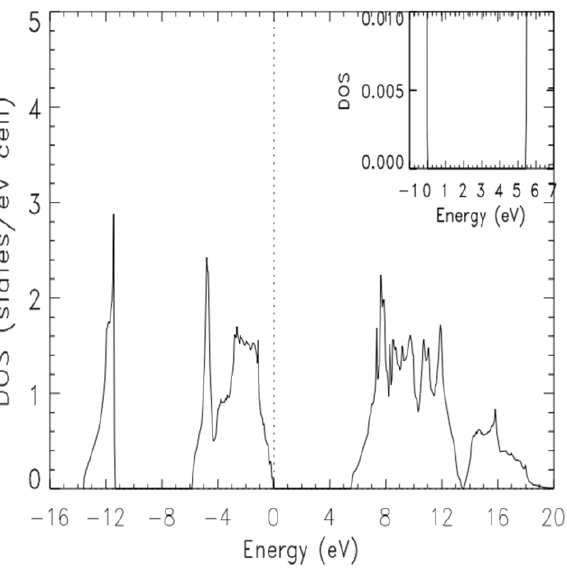
Figure 2. The total density of states (DOS) of zb-BeS, derived from the ground state band structure from calculation III.